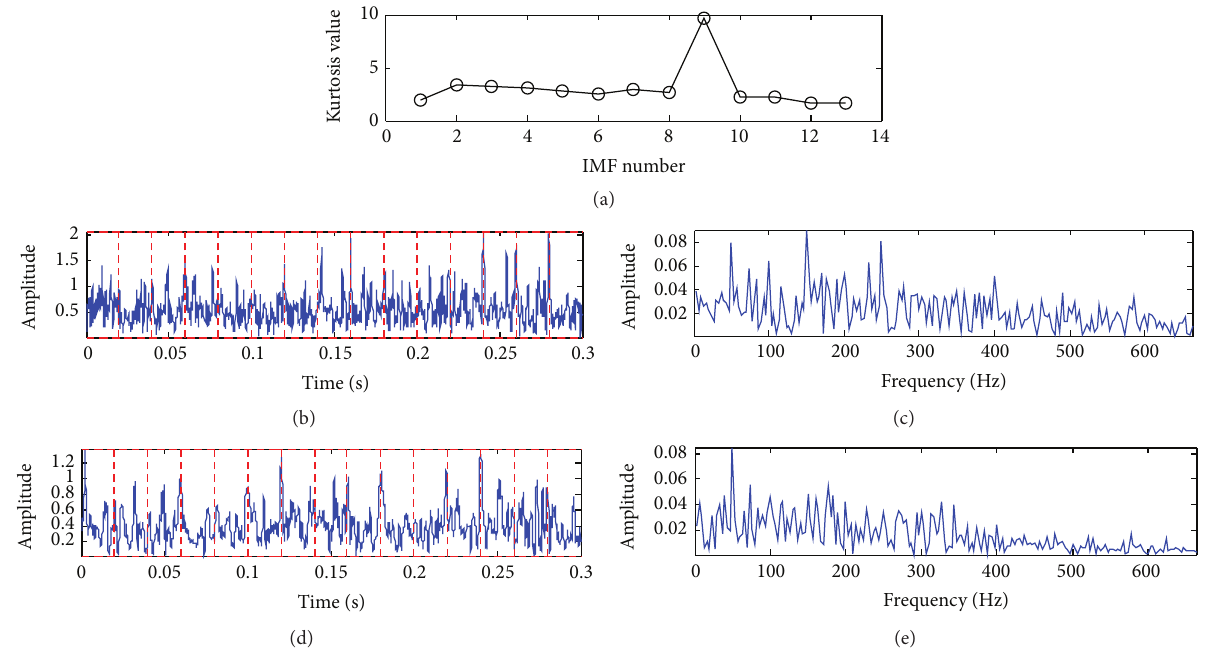
Figure 13: Analyzed results of the simulated signal with double resonance bands shown in Figure 8(b) by the EMD-based demodulation method: (a) kurtosis curve of 13 decomposed IMFs; (b) envelope waveform of IMF2; (c) envelope spectrum of IMF2; (d) envelope waveform of IMF3; (e) envelope spectrum of